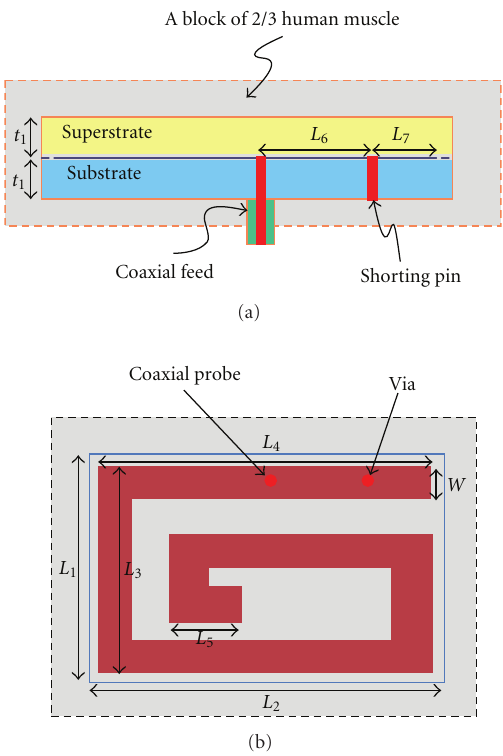
Figure 2: Geometry of embedded spiral-shaped microstrip im- plantable antenna, (a) side view, (b) top view.